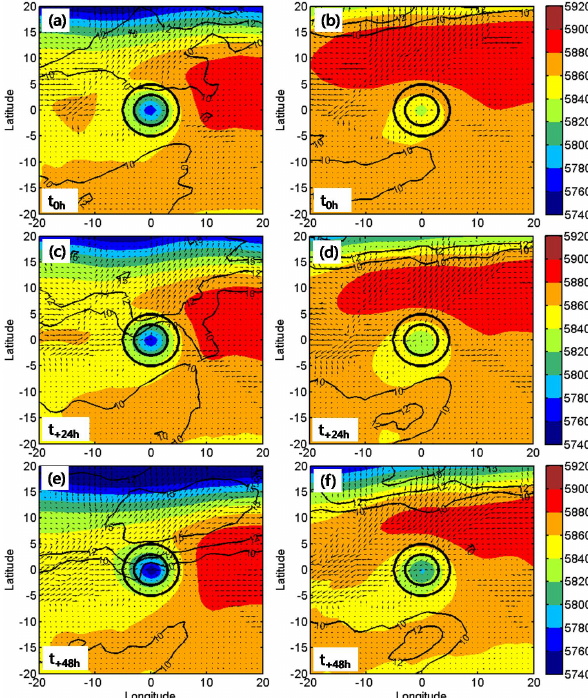
Figure 9. GFS-derived fields for the composites of the 500hPa geopotential height at 20gpm intervals (shading), magnitude of the deep-layer vertical wind shear (contours, 2ms − 1 intervals starting at 10ms − 1 ) for (left) weakening and (right) strengthening events at time (top) t 0h , (middle) t + 24h and (bottom) t + 48h . Vectors in the left (right) panels mean the vector differences of the vertical wind shear between the weakening (strengthening) and the strengthening (weakening) cases, respectively. The two black solid circles are 3 ◦ - and 5 ◦ -radius circles centered on the storm.